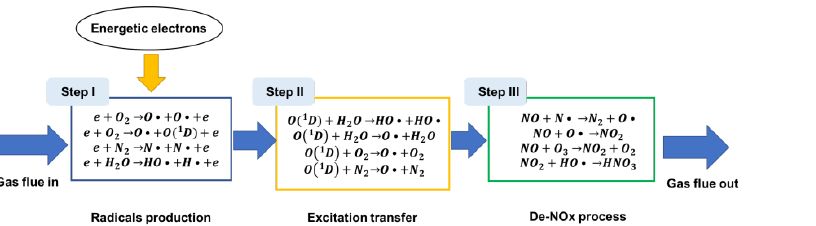
Figure 4. Removal process of NOx by the collision of electrons with neutral molecules. Adapted from [51] with permission from Elsevier, Copyright 2021. Table 3. Standard oxidation potentials of representative oxidants used in gas–liquid oxidation. Oxidant Half-Cell